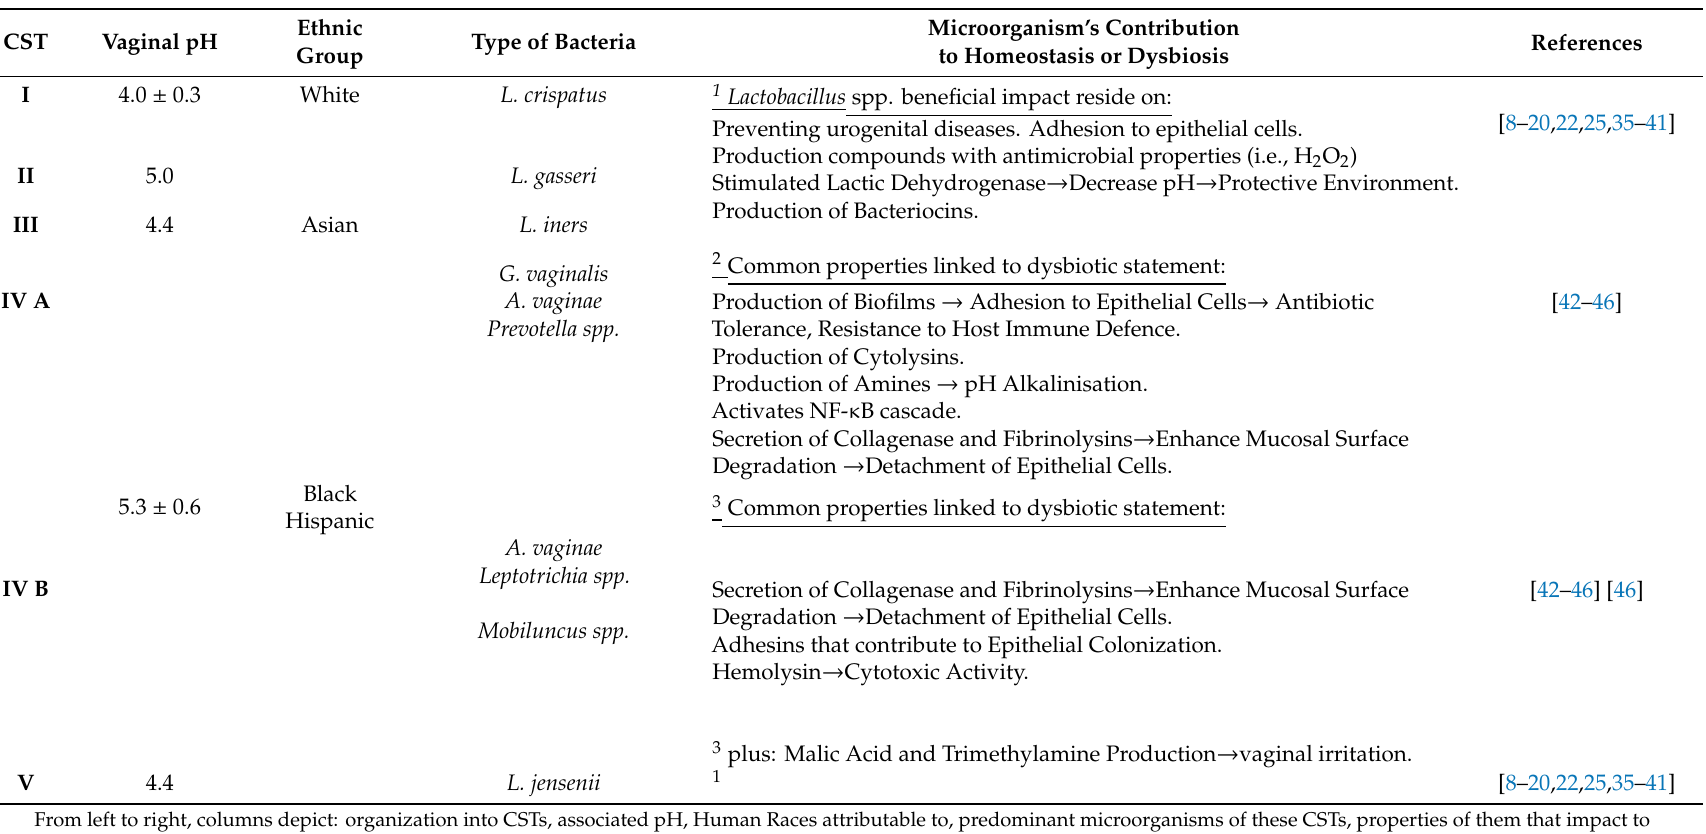
Table 1. Organization of the vaginal flora into community types (CSTs) in asymptomatic non-pregnant, sexually active women and their contribution to homeostasis (wellness) or vaginal dysbiosis